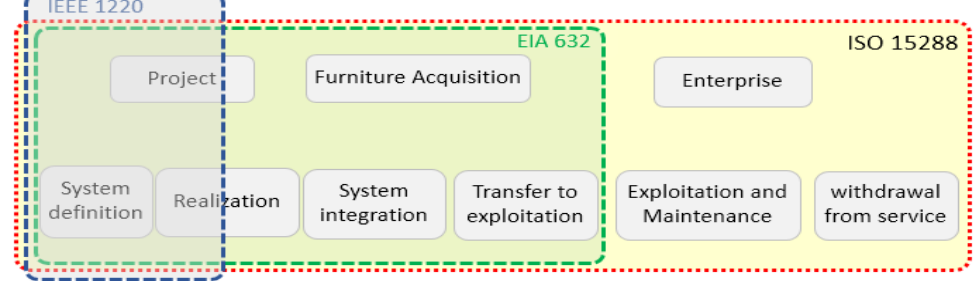
Figure 2. The three system engineering standards and their ranges